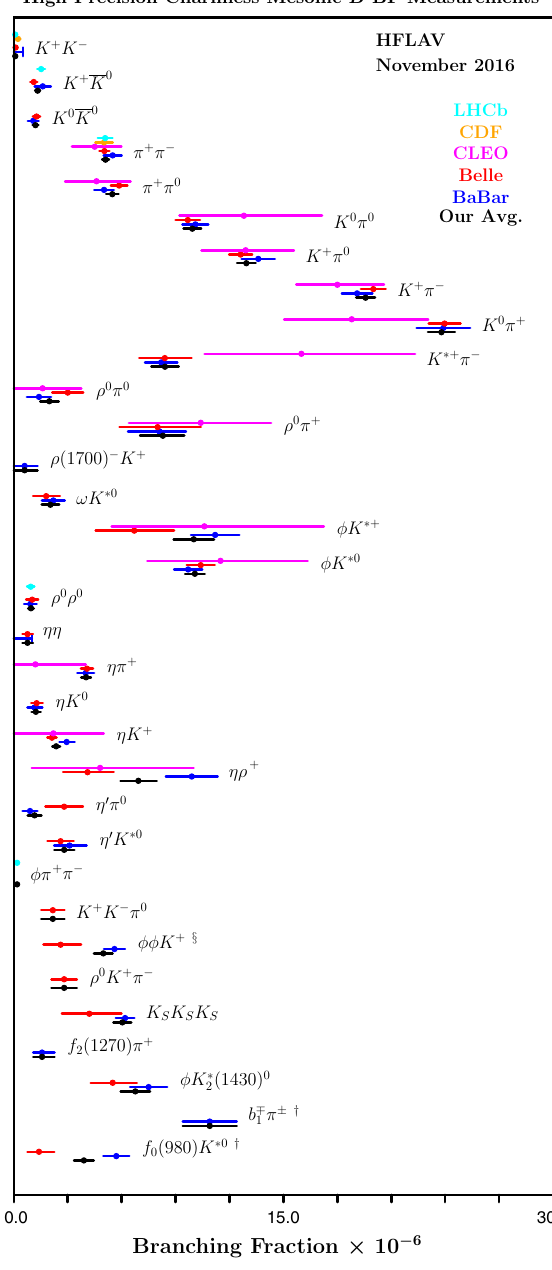
Fig. 176 Selection of high-precision charmless mesonic B meson branching fraction